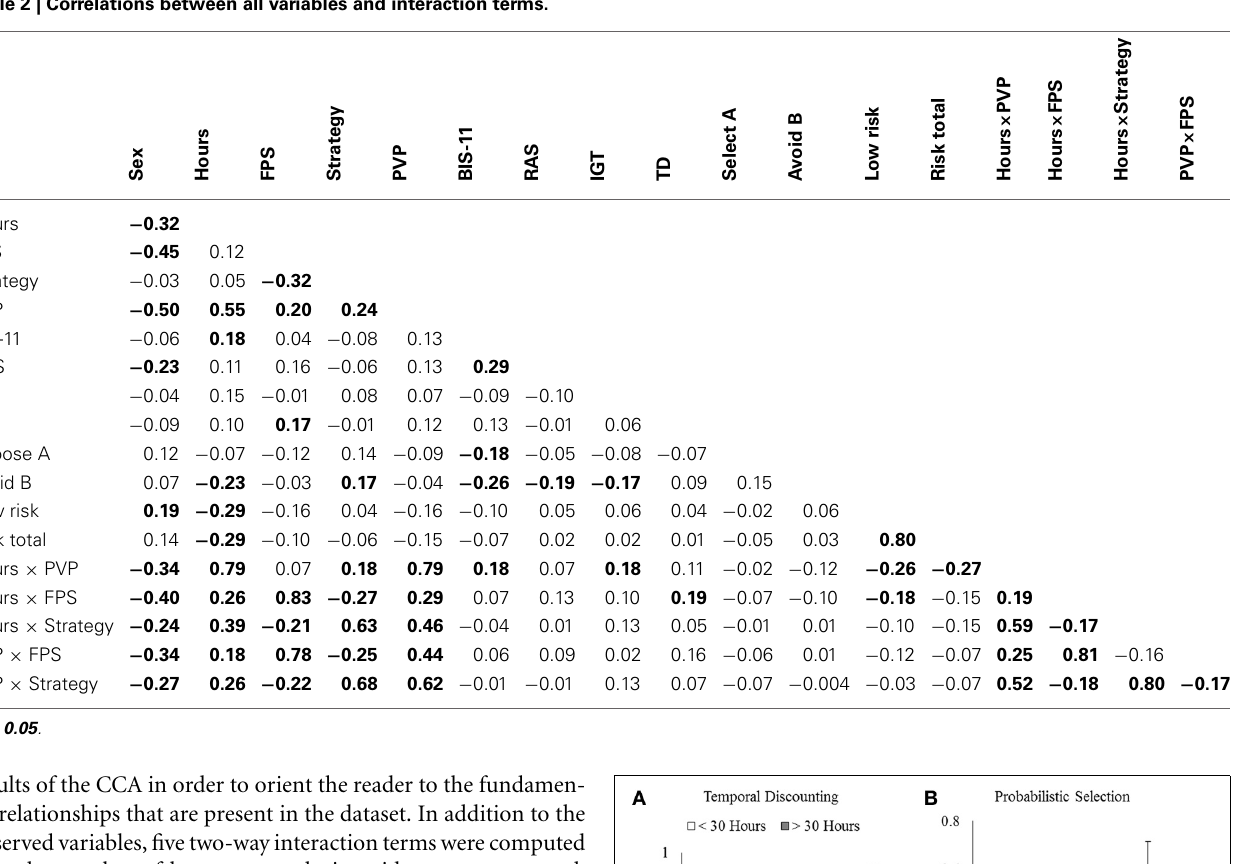
sitivity to negative feedback in the probabilistic selection